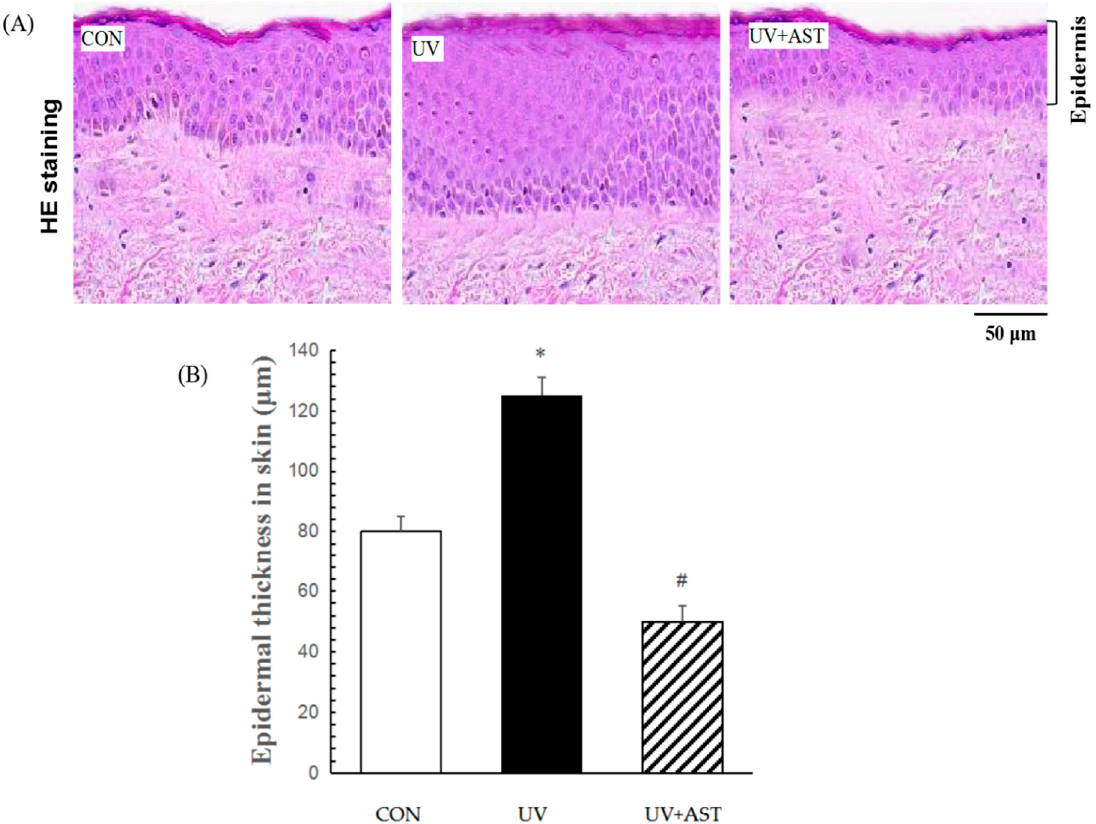
Figure 2. The effect of AST on epidermal thickness in the dorsal skin of ultraviolet (UV)-induced mice. ( A ) Hematoxylin and eosin staining. Scale bar = 50 µ m ( B ) Treatment with AST significantly suppressed the UV irradiation-induced increase in epidermal thickness. * p < 0.01 vs. control mice; # p < 0.01 vs. UV-induced mice.